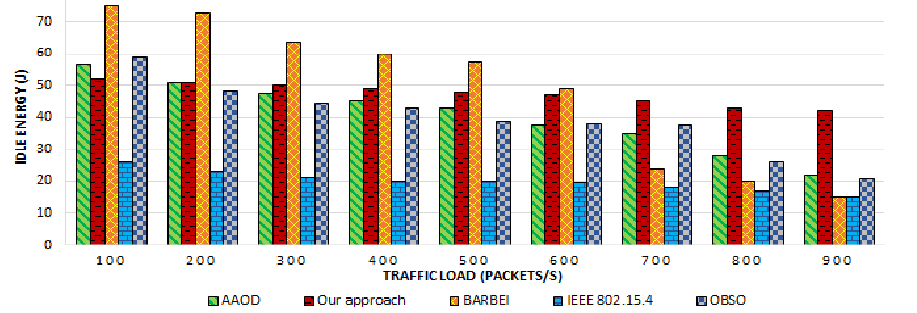
Figure 12. Sleep energy consumption.